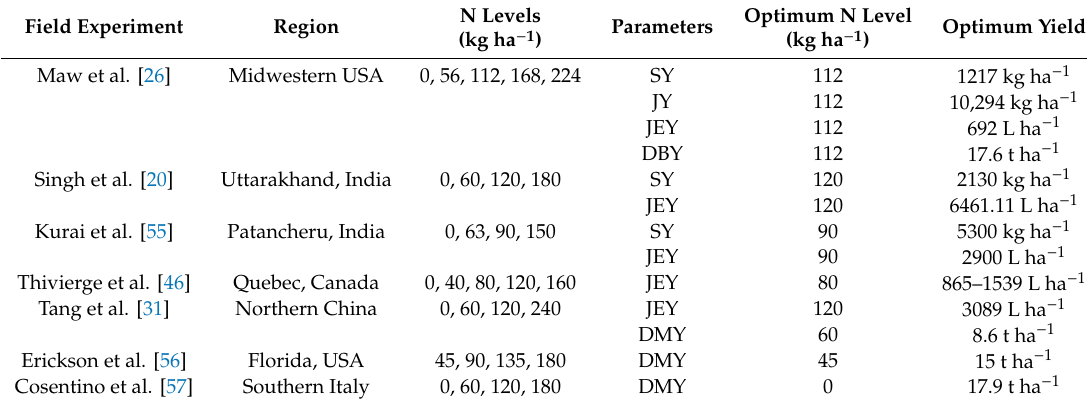
Table 6. Optimization of dry matter and bioethanol yields in diverse ecological conditions under di ff erent N fertilization